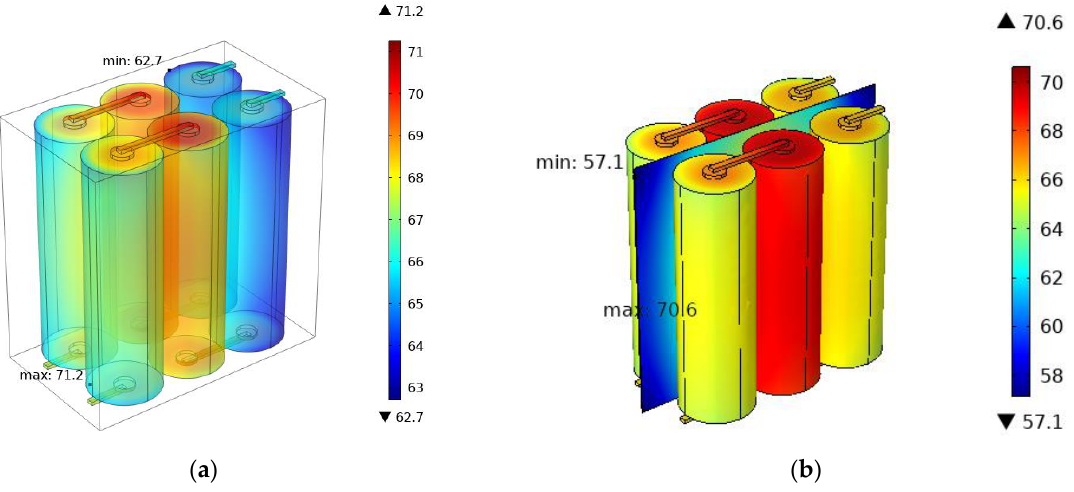
Figure 15. ( a ) Temperature distribution inside the battery pack without the heat spreader; ( b ) tem-